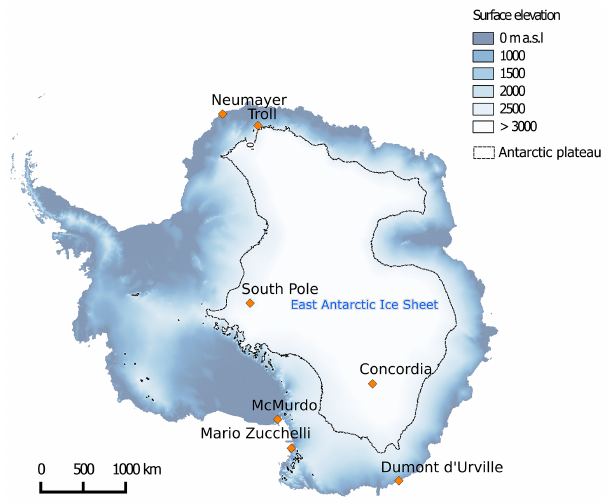
Figure 1. Map of Antarctica showing surface elevation (meters above sea level, ma.s.l.) and the position of stations where atmo- spheric mercury measurements have been performed with modern on-line instruments. The black line shows the periphery of the high altitude plateau